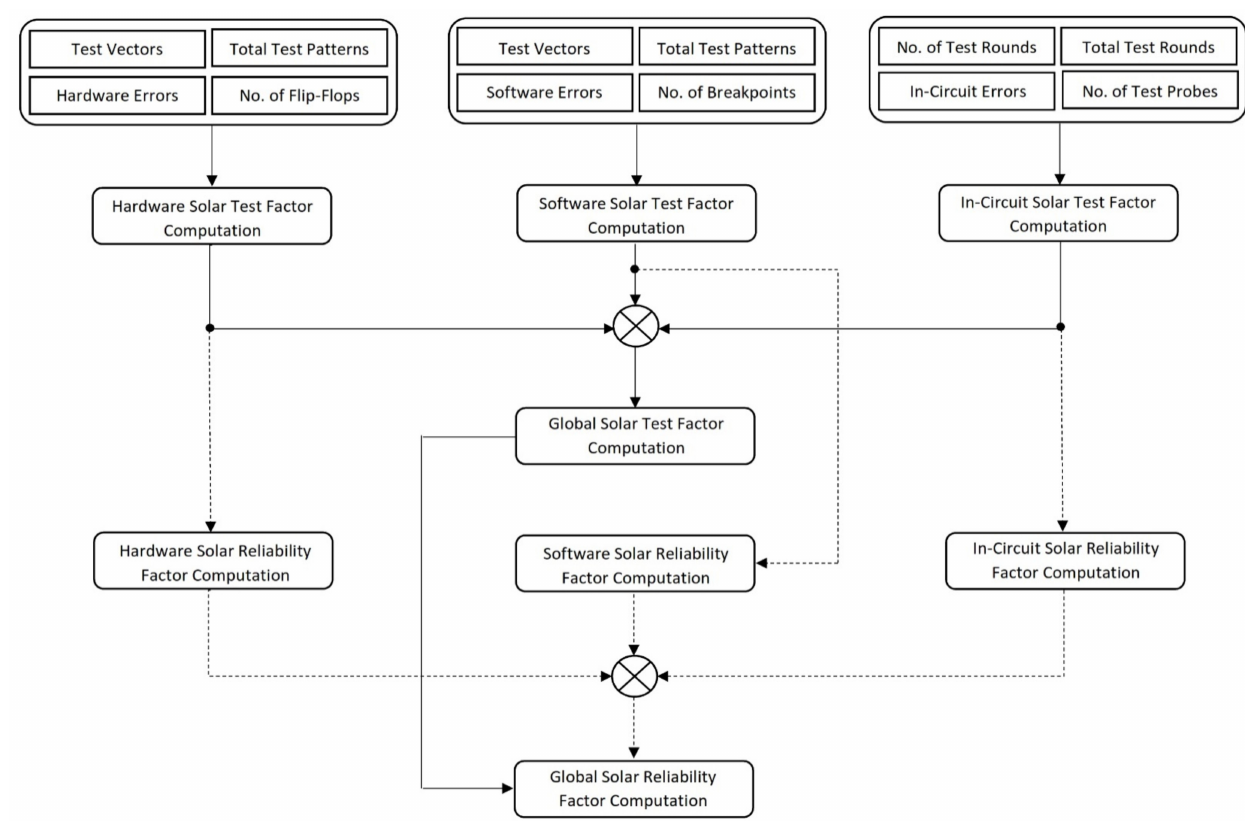
Figure 1. Conceptual computation diagram for determining the solar test factor and solar reliability factor of solar tracking